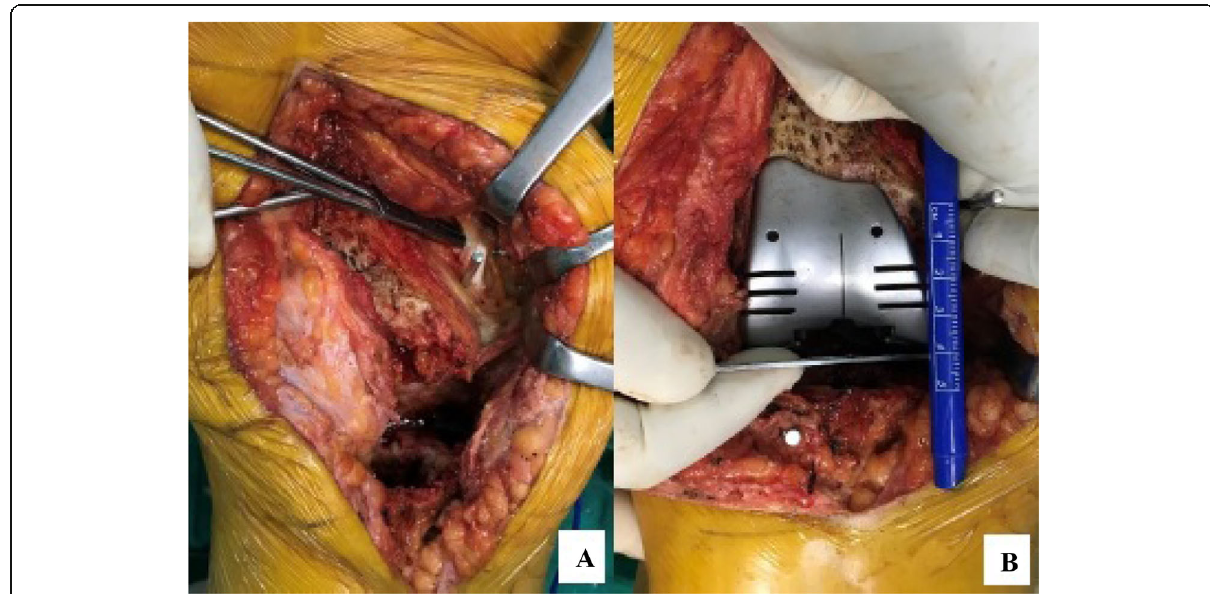
Fig. 1 a. Kirshner wire placed at the insertion of the Adductor Magnus muscle (Adductor Tubercule). b. Joint line restorations with femoral trial prothesis according to calculations from AT